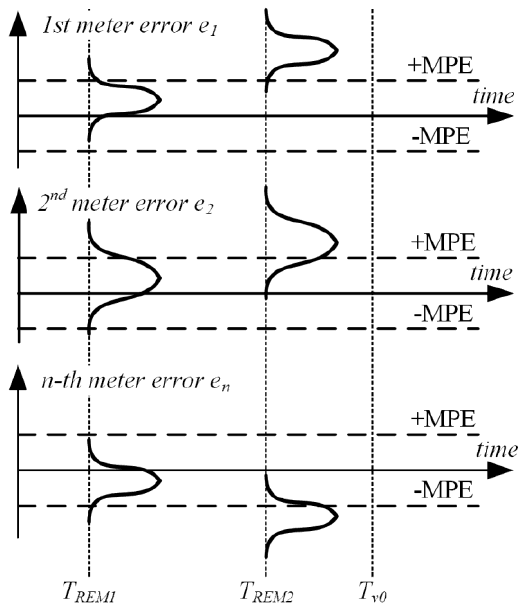
Figure 4. Time diagram of a meter batch’s in-service surveillance assisted by remote error monitoring.